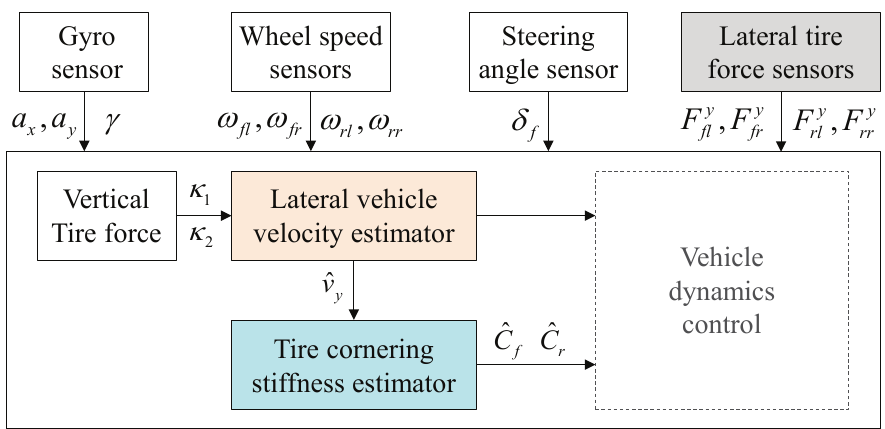
Figure 6. Illustration of lateral vehicle velocity and tire cornering stiffness estimators.